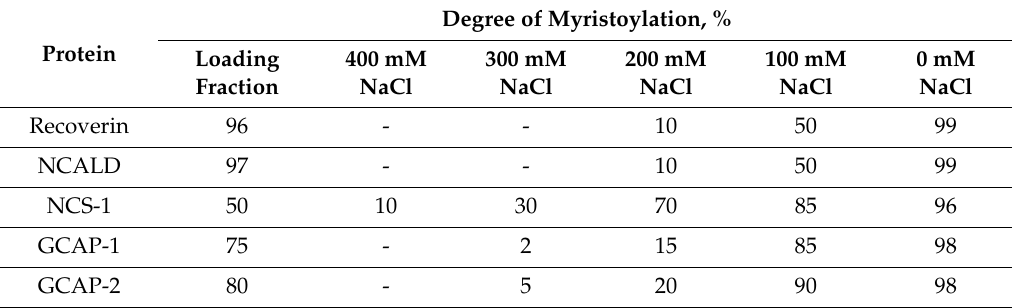
Approximate content of myristoylated NCSs in the fractions from Butyl Sepharose chromatography upon use of step gradient of